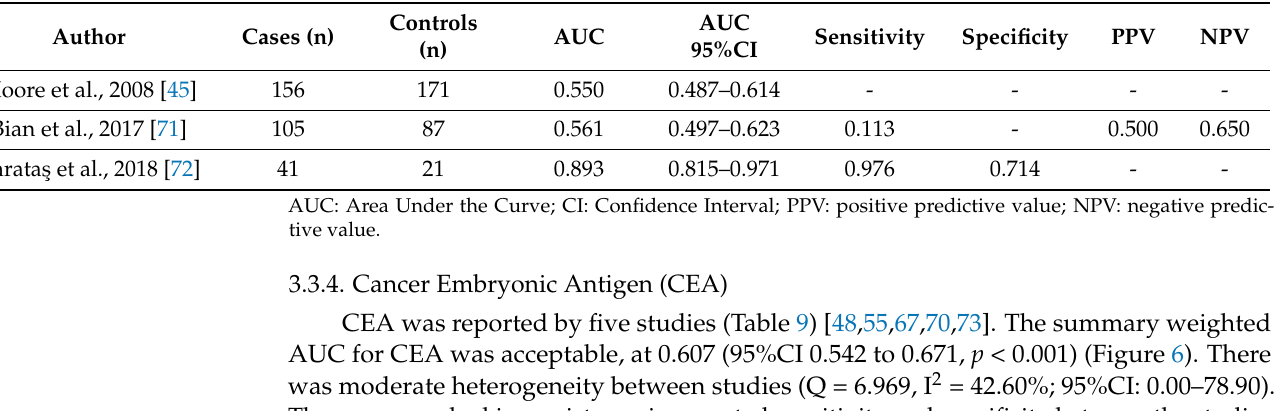
Table 8. Summary table of the performance of CA-72-4.